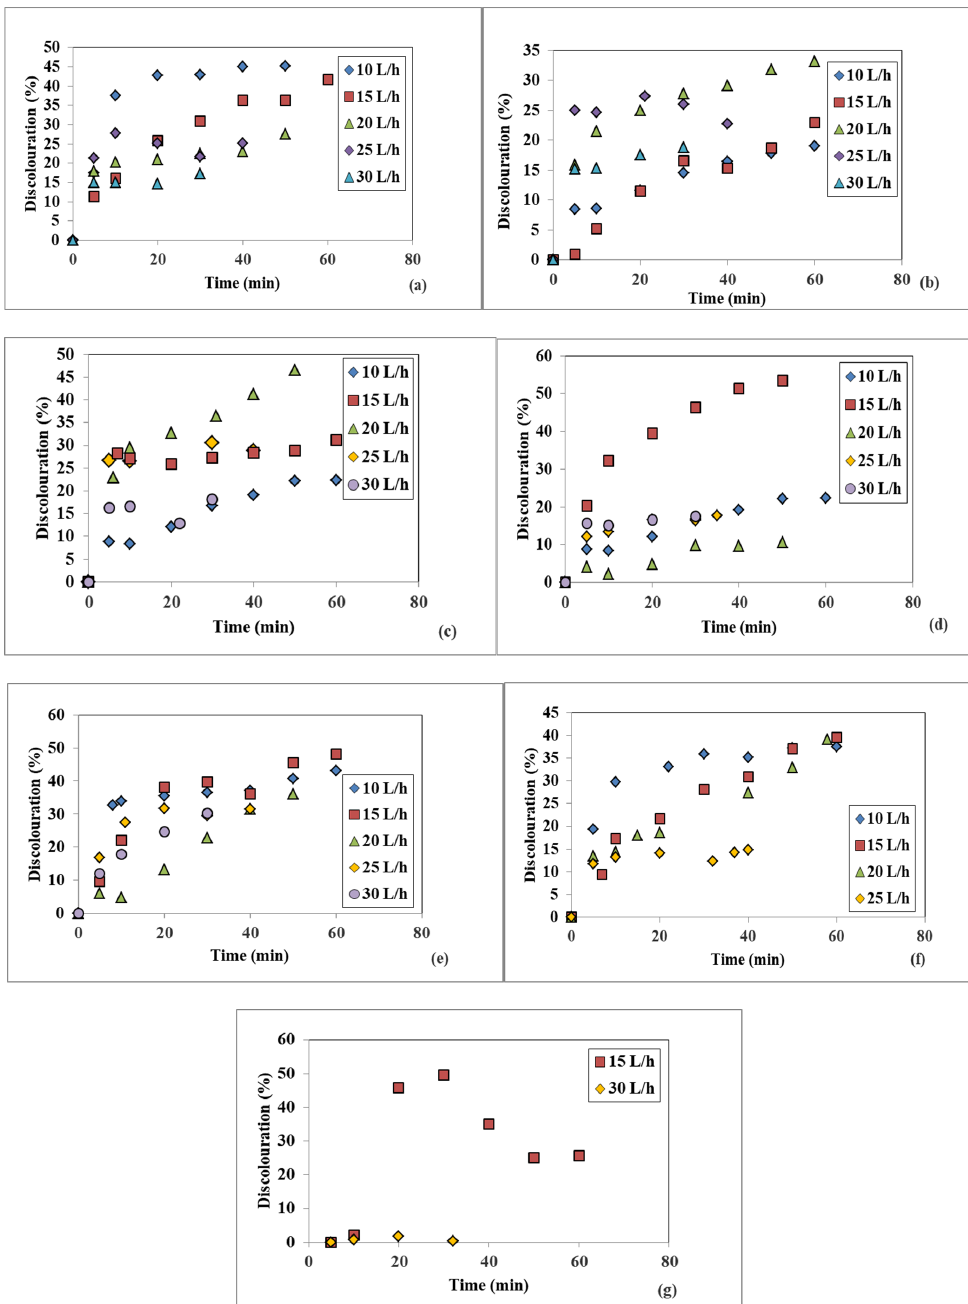
Figure 4. Influence of the WW flowrate on the discoloration at different disc rotational speeds: ( a ) 100 rpm, ( b ) 250 rpm, ( c ) 400 rpm, ( d ) 550 rpm, ( e ) 850 rpm, ( f ) 1200 rpm, ( g ) 1500 rpm. The influence of five different WW flowrates on the suspended solids (SS) removal at seven different disc rotational speeds stayed constant, and are shown in Figure 5a–g. Similar to discoloration, the SS removal increases over time, attaining maximum values for certain disc rotational speeds and WW flowrates. However, the experimental conditions for the highest SS removal are not identical to the ones used when the maximum discoloration was obtained. Thus, at a 100 rpm disc rotational speed, the largest suspended solids removals were 57.32% for a 15 L / h feeding WW flowrate and 45.98% at 20 L / h, both after a 60 min measured SD operating time interval (Figure 5a). When the rotational speed was 250 rpm, the suspended solids removal had a maximum of 54.29% at 10 L / h, and reasonably